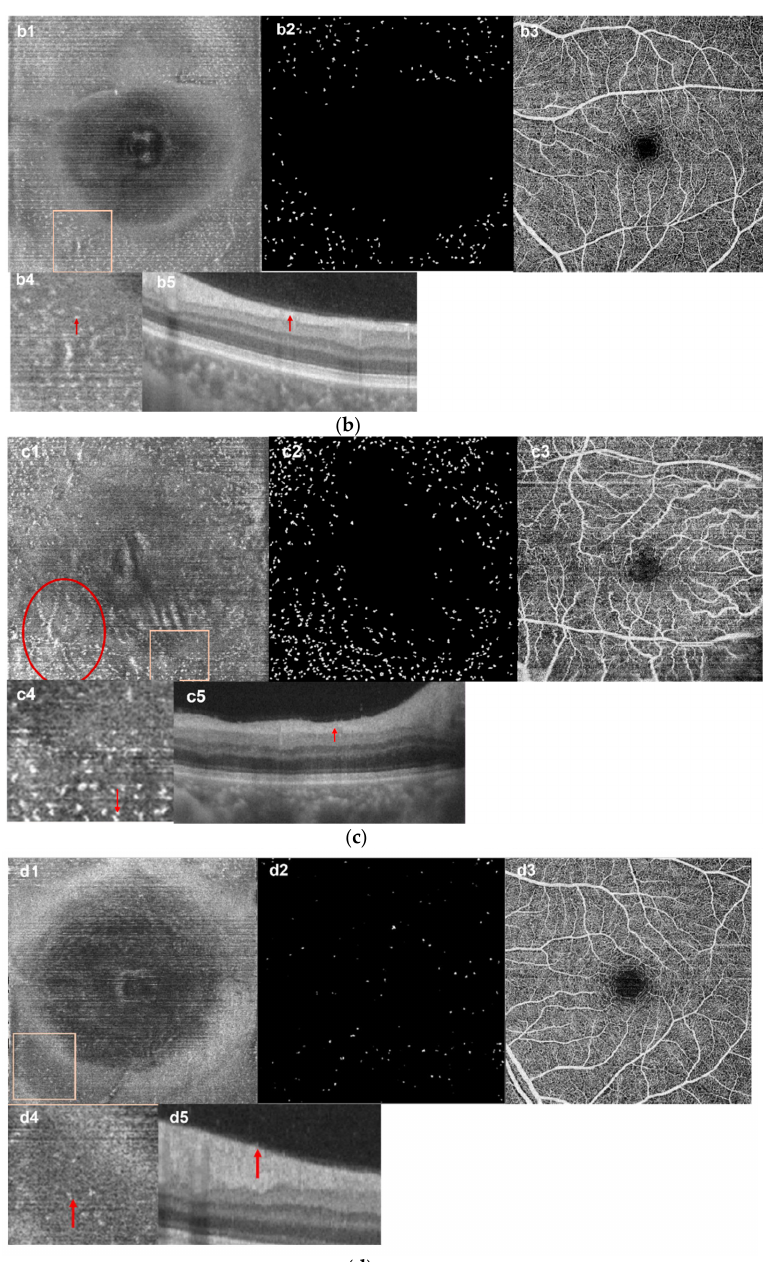
Figure 3. The density of MLCs increased in RVO eyes. ( a ) images from an acute CRVO patient’s affected eye. ( a1 ) En face OCT slab of MLCs. ( a2 ) Binarized image of ( a1 ). ( a3 ) OCTA images showing non-perfused regions. ( a4 ) Magnified image from the pane in ( a1 ). ( a5 ) OCT B-scan images. MLCs on B-scan appeared as little embossment (red and blue arrows corresponding to the same color arrows in ( a4 )). ( b ) Images from the fellow eye of ( a ). ( b1 ) En face OCT slab of MLCs. ( b2 ) Binarized image of ( b1 ). ( b3 ) OCTA images. ( b4 ) Magnified image from the pane in ( b1 ). ( b5 ) OCT B-scan images. Although MLCs of the normal eye on B-scan also appeared with little embossment (red arrow), it was not as obvious as in the RVO eye. ( c ) Images from another acute CRVO eye. ( c1 ) En face OCT slab of MLCs, some of MLCs distributed along the blood vessels (red circle). ( c2 ) Binarized image of ( c1 ). ( c3 ) OCTA images. ( c4 ) Magnified image from the pane in ( c1 ). ( c5 ) OCT B-scan images (the red arrows of ( c4 , c5 ) correspond). ( d ) Images from the fellow eye of ( c ). ( d1 ) En face OCT slab of MLCs. ( d2 ) Binarized image of ( d1 ). ( d3 ) OCTA images. ( d4 ) Magnified image from the pane in ( d1 ). ( d5 ) OCT B-scan images (the red arrows of ( d4 , d5 )